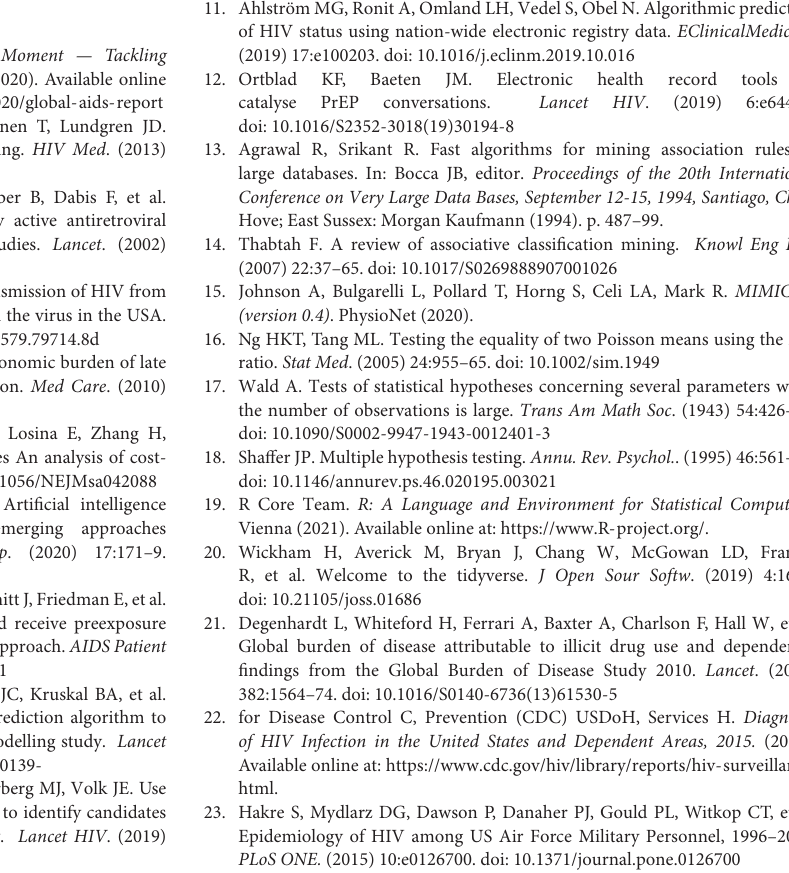
Supplementary Table 1 | The rules in the final